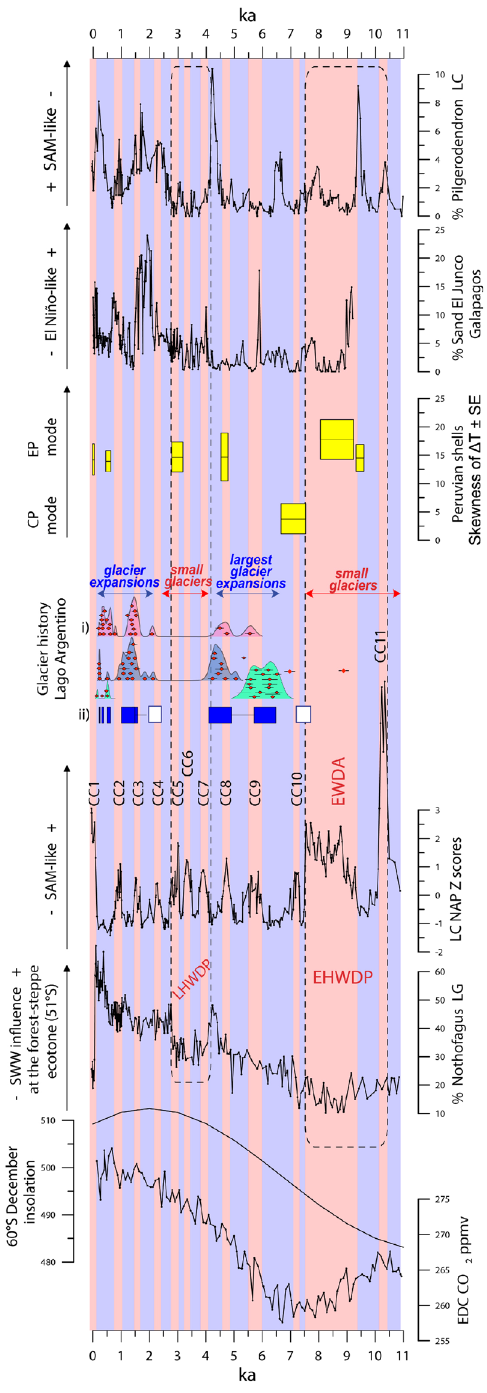
Figure 3. Southern Hemisphere climate comparisons. We compare the last 11,000 years of the standardized Lago Cipreses Non Arboreal Pollen curve (LC NAP)(D) with the the EPICA Dome C record of atmospheric 13 CO 2 (A); the December insolation at 60°S (B); the % Nothofagus abundance in Lago Guanaco (LG) 21 (C), a proxy for precipitation of SWW origin in the Torres del Paine area, downwind from LC; a summary of the cosmogenic and radiocarbon constraints (E) on Patagonian glacier history in the Lago Argentino sector 45,46 , we show 10 Be ages ( ± 1 σ ), summed probability density plots of all the ages (i.e., camel humps), and mean moraine ages (blue and white rectangles) based on published 10 Be and 14 C data. The ‘camel humps’ essentially reflect times of moraine formation and hence glacier expansion relative to today. (F) Shows the skewness of delta temperature ( ± standard error) from Peruvian shells interpreted 5 as a proxy for Eastern Pacific (EP, values > 0) or Central Pacific (CP, values < 0) modes in El Niño regime; (G) the % sand record from lake El Junco in Galapagos 38 (G), a proxy for El Niño activity in the eastern equatorial Pacific; and (H) the % Pilgerodendron abundace in the LC record in its original units and standardized units in the z-scored secondary scale, which